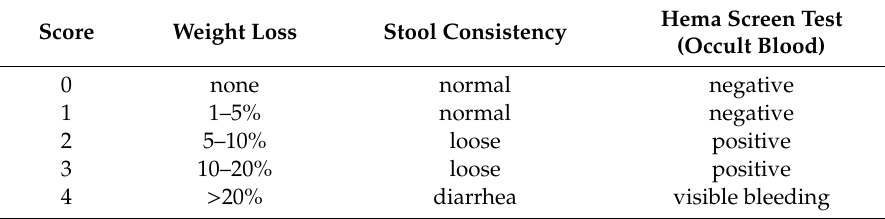
Table 1. Disease activity